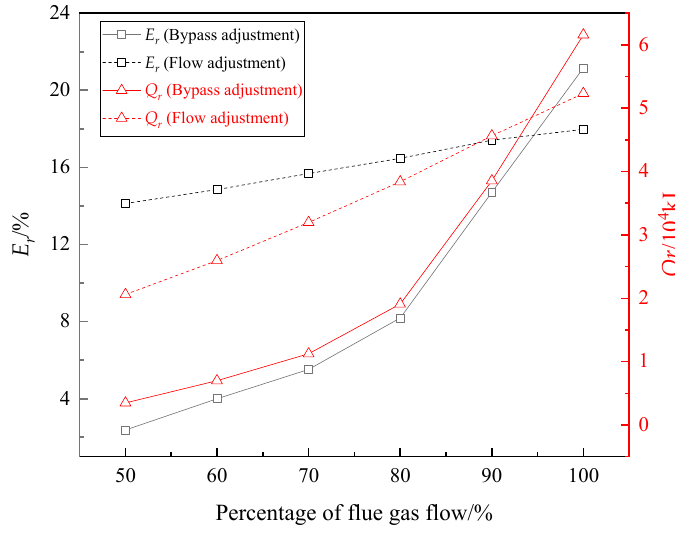
Figure 9. E r and Q r as flue gas flow changed.